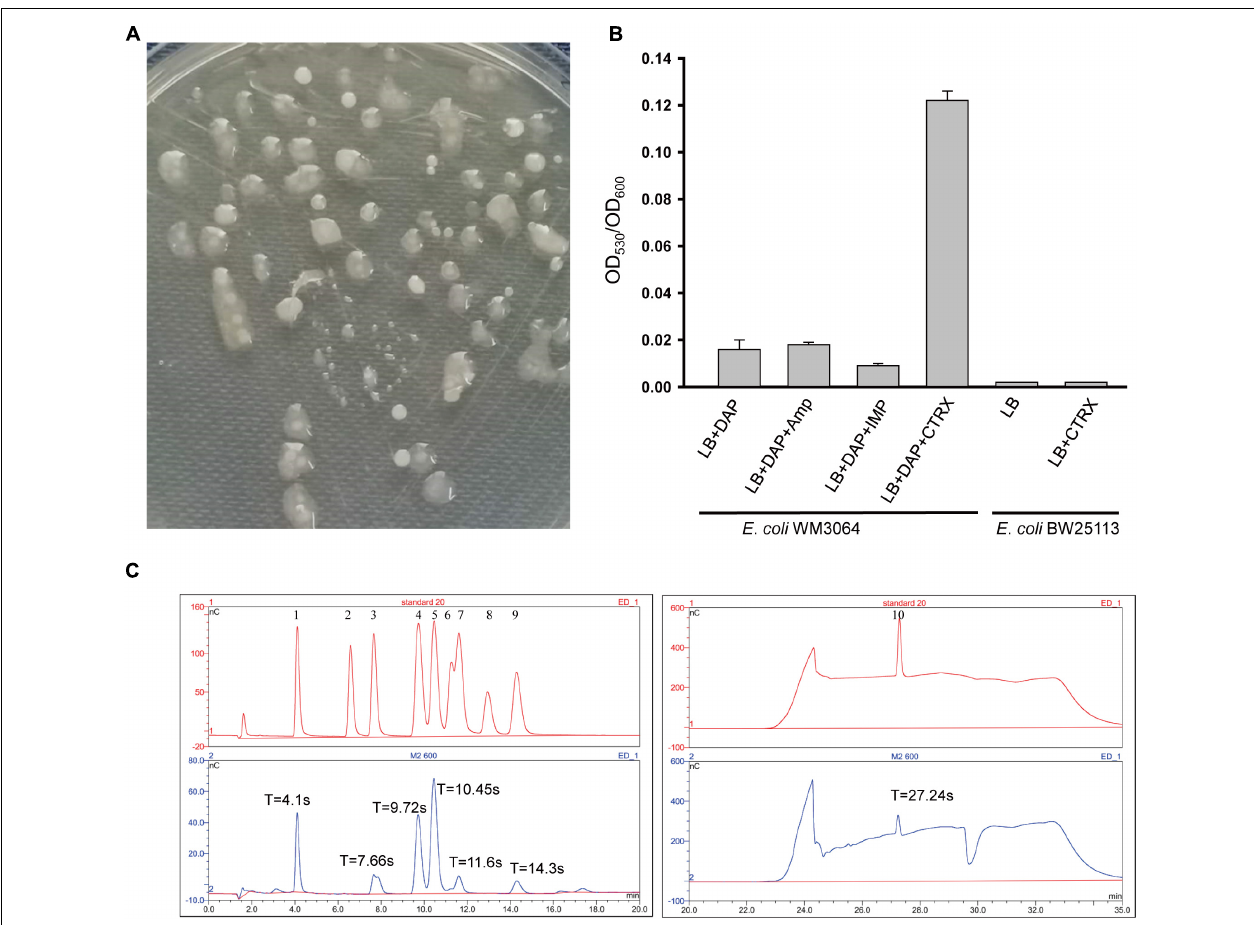
FIGURE 1 | Production and monosaccharide composition of EPS-m2. (A) Mucoid colonies of EPS-m2-producing bacterial on LB plates containing 0.3 mM DAP. (B) EPS-m2 yields in LB medium with different antibiotic agents were determined by the ratio of OD 530 to OD 600 . (C) The monosaccharide composition of EPS-m2 was measured by using the DIONEX ICS 5000 system. The picture of "standard 20" represents the 10 standard monosaccharides. 1–10 represents the peaks of the standards L-fucose, L-rhamnose, L-arabinose, D-galactose/N-acetyl glucosamine, D-glucose, D-mannose, D-xylose, D-fructose, D-ribose, and D- glucuronic acid, respectively. "T" represents the retention time for absorption peaks. Amp, ampicillin; IMP, imipenem; CTRX, ceftriaxone. The concentrations of these three antibiotics used in this study were all 0.5 µ